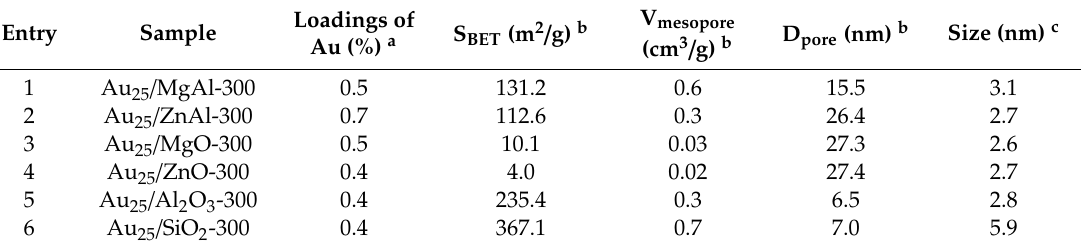
Table 1. Textural properties of di ff erent supported gold